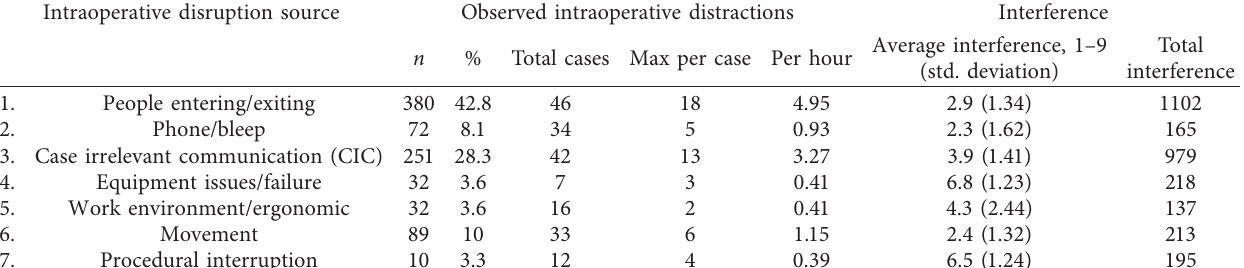
Table 2: Observed intraoperative distraction (total and frequency) and interference per disruption